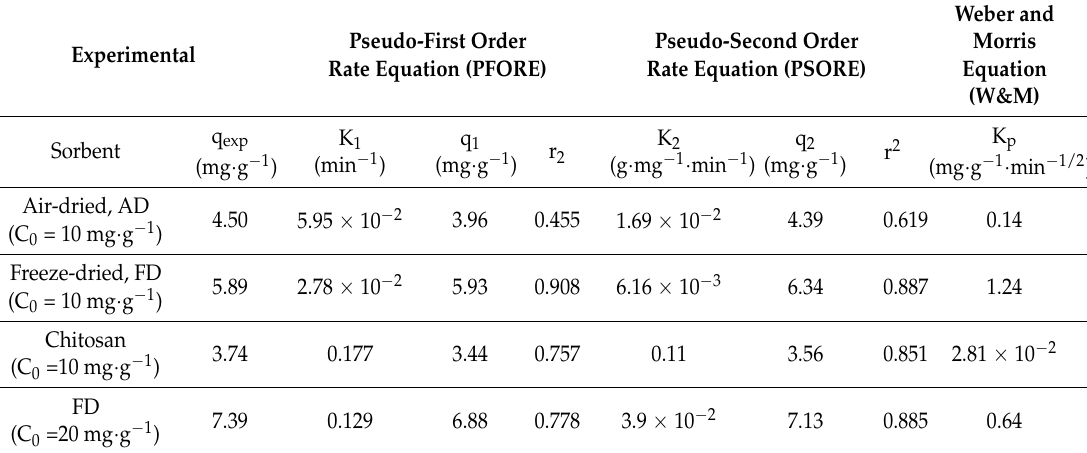
Table 3. Kinetic parameters of sorbent